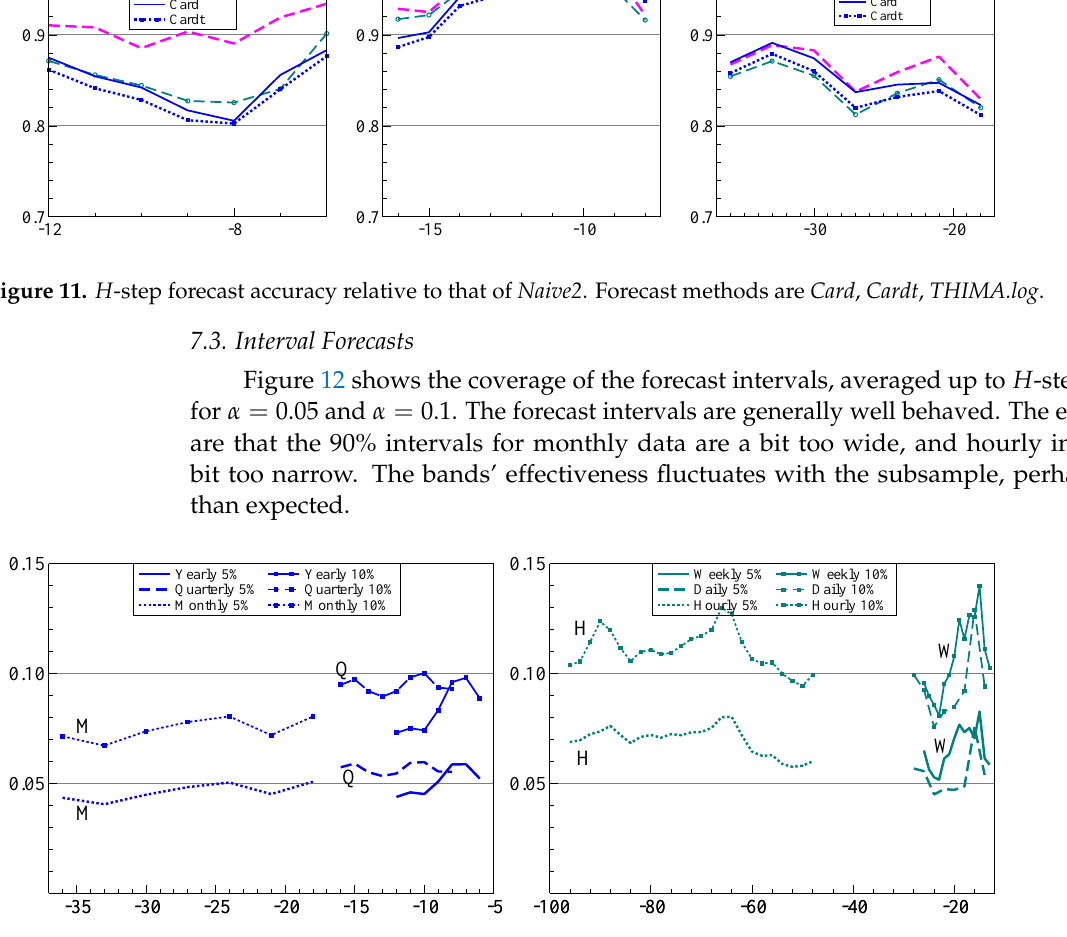
Figure 12. Average rejection of 95% and 90% H -step forecast intervals for all frequencies of M4, retaining from 2 H to H observations for